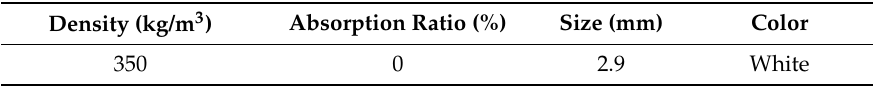
Table 8. Properties of EPS beads.